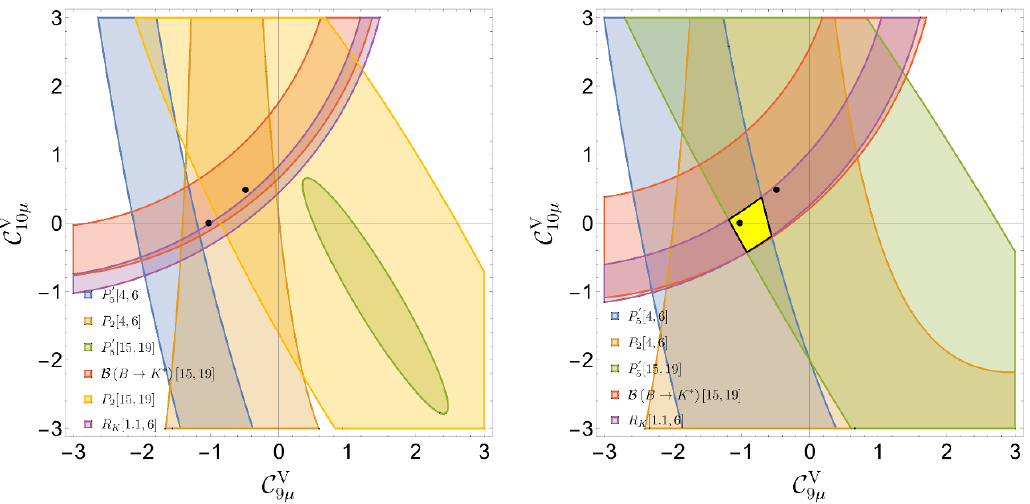
Figure 3. 68.3% (left) and 95% (right) CL solutions regions for the observables discussed in the main text in the ( is only shown in the left